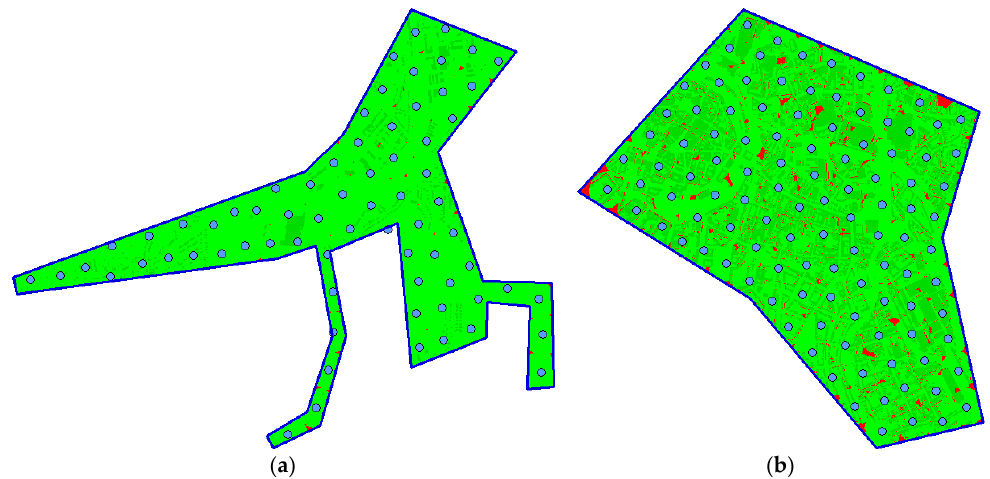
Figure 14. The best solution found: ( a ) instance sc03; ( b ) instance sc04.